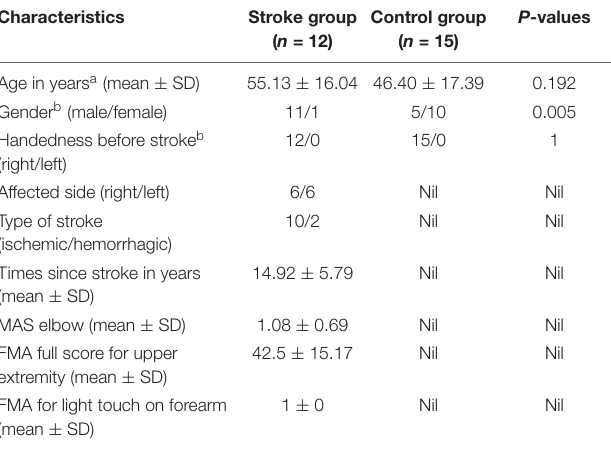
TABLE 1 | Demographic characteristics of the